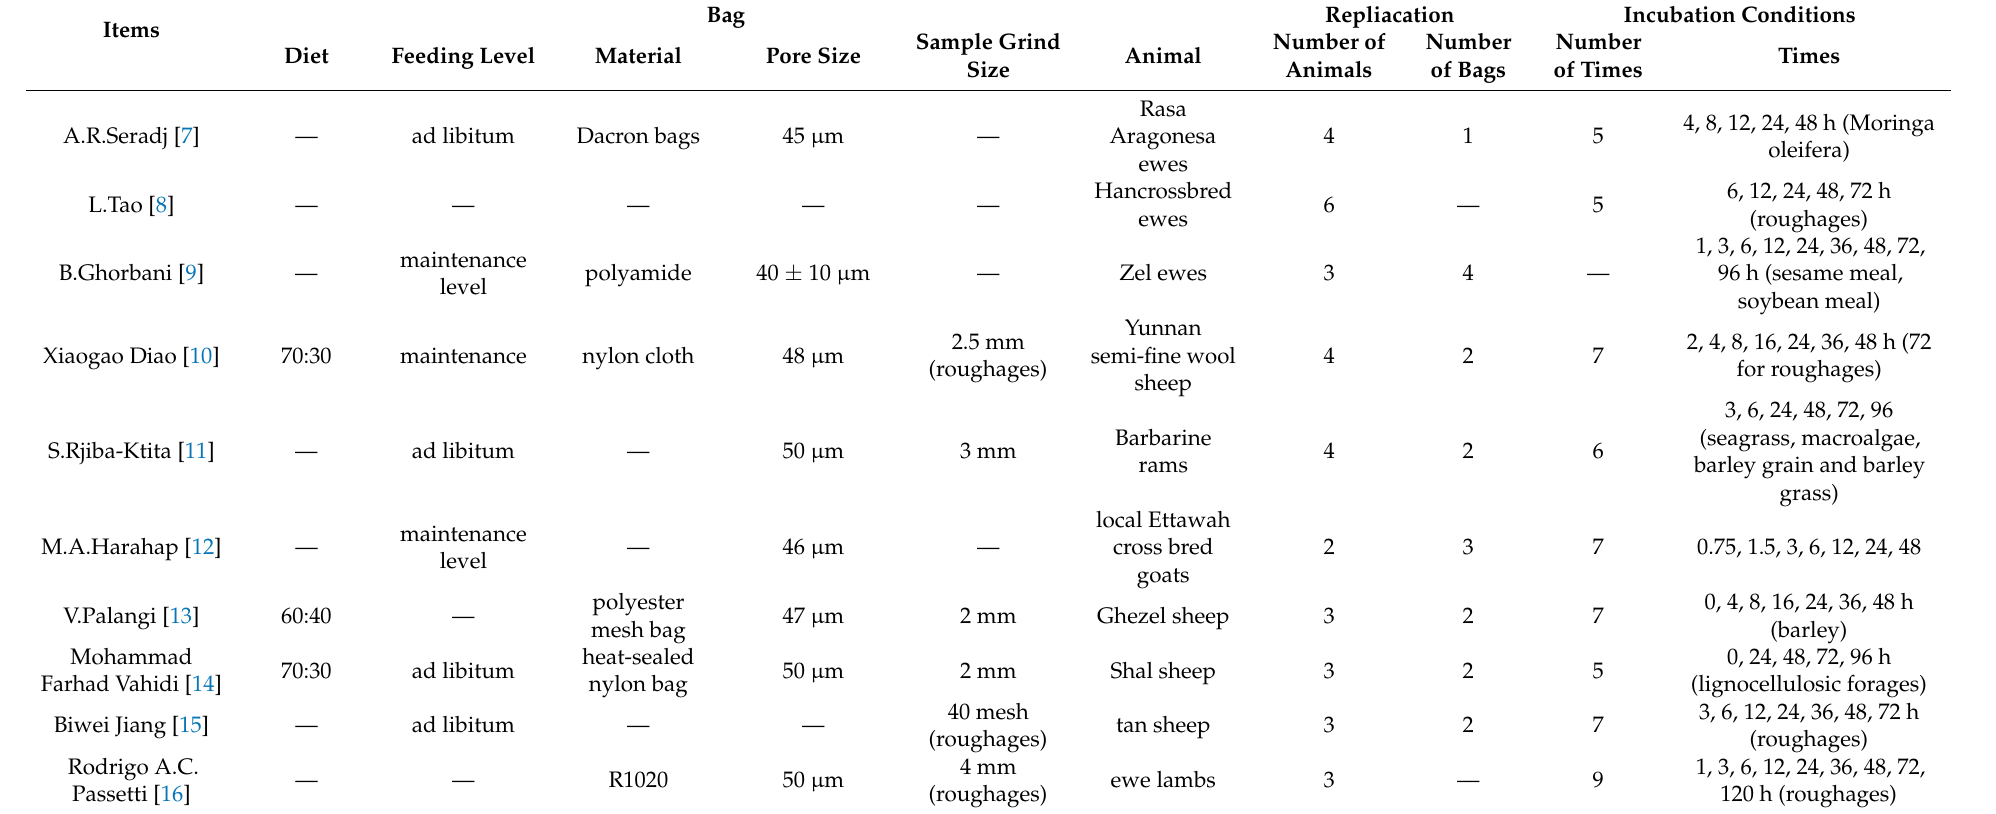
Table 1. Comparison of recent studies on the application of nylon bag technique for rumen degradability in sheep.